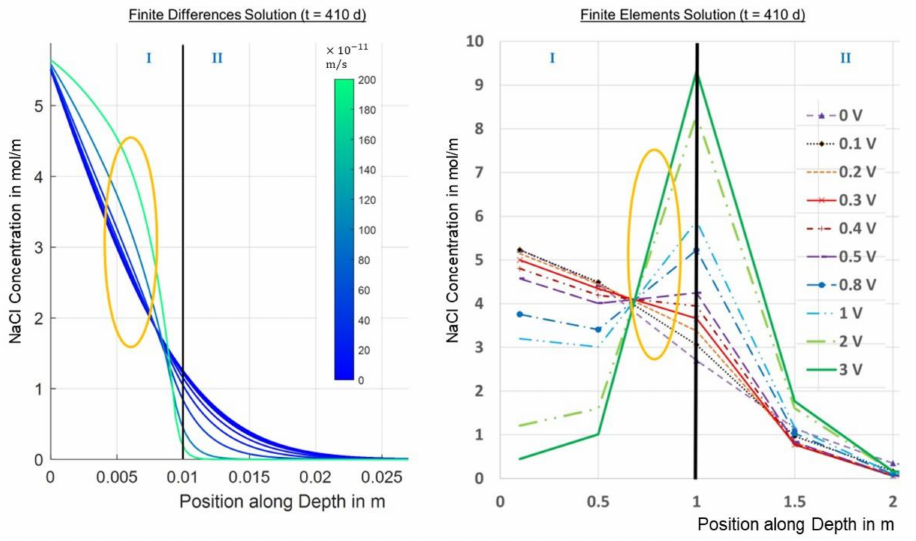
Figure 18. Investigated effect in the finite differences and the finite elements solution for t = 410